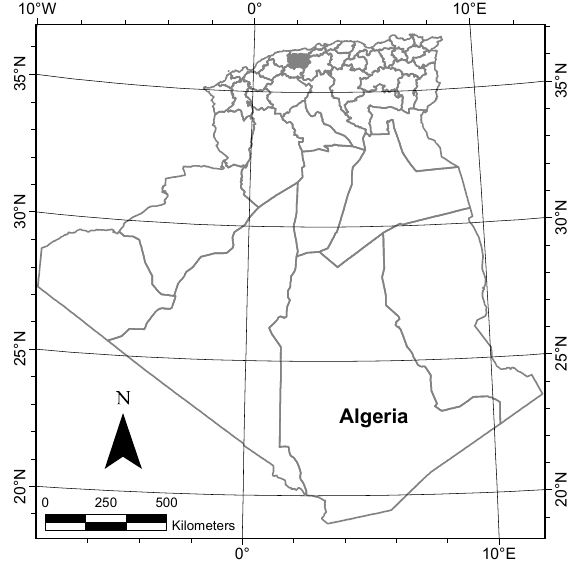
Figure 2: Map localisation of the studied area in Algeria. global idea of CVA consists in computing the spectral change vectors by the subtraction of pairs of spectral bands. A change vector is described by the magnitude of change and the angle of change between two images obtained at the moment t 1 and t 2 (Lu et al., 2004). When a threshold is applied to this change vector based on their magnitude, then a possible change is determined, as described in (Chen et al., 2003) and (Nackaerts et al., 2005). The Modified Supervised Change Vector Analysis Posterior prob- ability Space (MSCVAPS) described in (Chen et al., 2011) has been taken as the initial point for this study. The first step in the methodology is to carry out a supervised classification that pro- vides a posterior probability map for each scene. In this work, 5 classes were used in the classification process: bare soil, dense vegetation, no-dense vegetation, urban and water areas. In our case, the Maximum Likelihood Classifier (MLC) was the chosen classification technique using the spectral bands b 1 , b 2 , b 3 , b 4 , b 5 and b 7 of the Landsat TM or ETM instrument, respectively. The supervised MLC classifier requires a training process that needs ground truth data. Since no in situ information was available, visual information was obtained from the satellite images. The total amount of training pixels used in the classification process were 10 . 74% of the total sub-area in China and 6 . 02% of the total sub-area in Algeria.